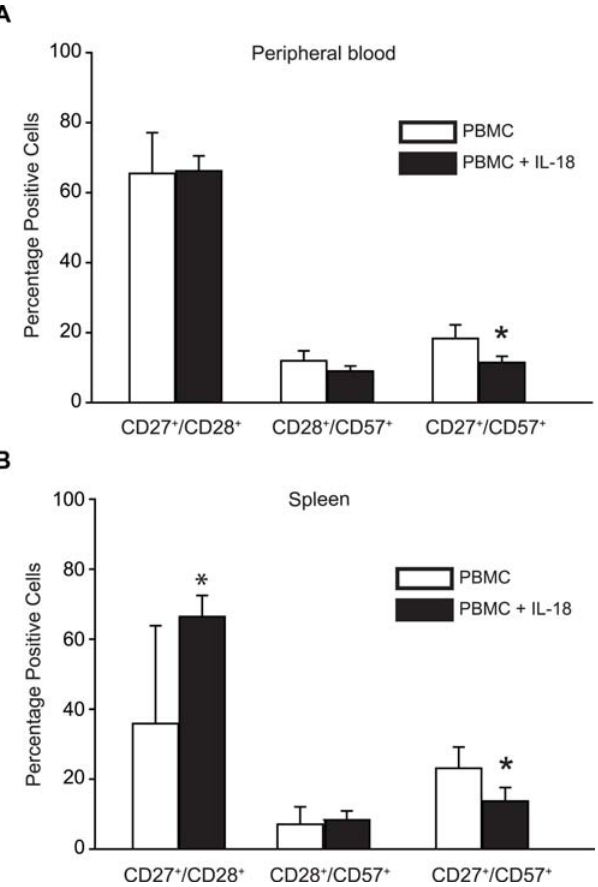
Figure 4. Effects of Human IL-18 on CD8 T Cell Differentiation in NOG mice. NOG mice were injected intraperitoneally with 5 6 10 6 human PBMCs, and beginning 1 day later, were injected with 15 m g recombinant human IL-18 daily for three weeks. Spleen tissue and peripheral blood were collected and analyzed for the presence of different CD8 + T cell subsets by flow cytometry. Cell populations were initially gated on human CD45 and human CD8. Filled bars represent values mean 6 s.d. obtained from IL-18-treated animals; open bars represent values obtained from mock-treated animals. The data in this figure represent results from one of two independent experiments. Asterisks indicate significant differences between mock- and IL-18- treated animals (p ,